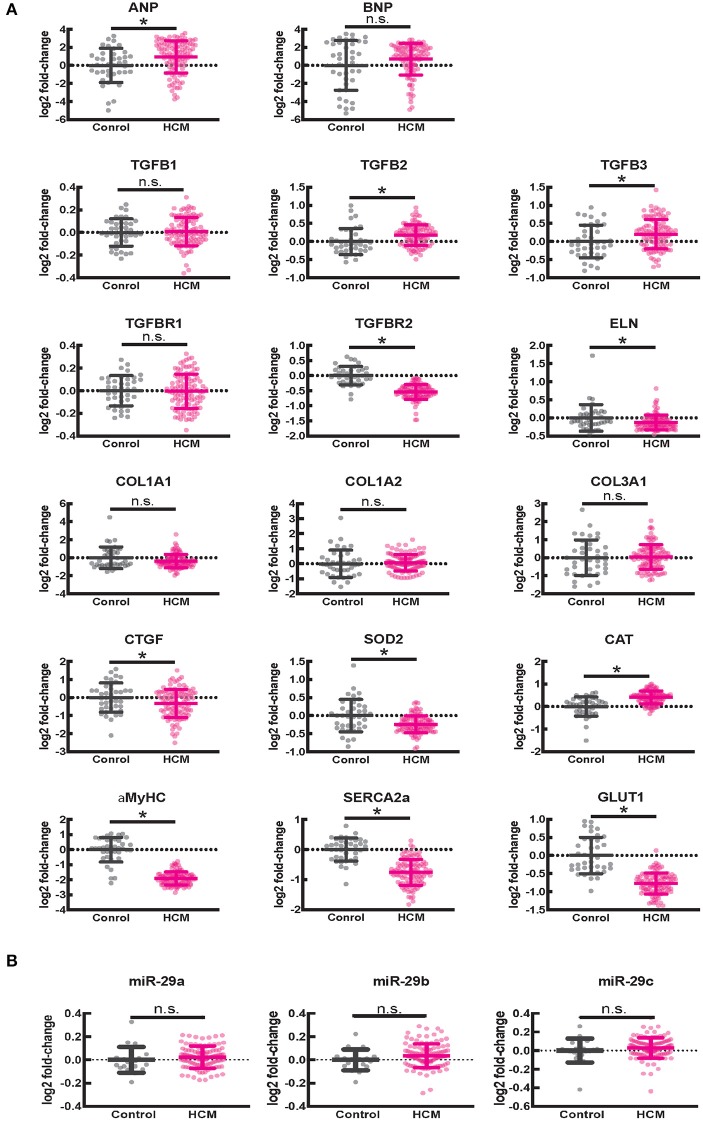
Gene expression in human ventricular septal tissue of HCM patients undergoing myectomy compared with control (healthy organ donor) hearts. (A) Summary of mRNA data (select pro-fibrotic and redox genes) from 105 HCM patients compared to data from 39 controls shows upregulation of TGFB2 and TGFB3 and downregulation of TGFBR2, ELN, αMYHC, SERCA2a, and GLUT1 genes. (B) Summary of data for miR-29a/b/c from 106 HCM patients compared with data from 20 controls shows no difference in expression of miR-29a/b/c between HCM patients and controls. *P < 0.05.